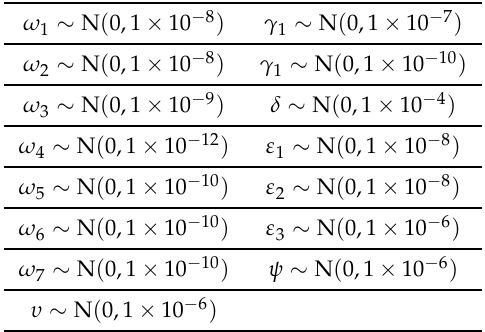
Figure 11. Initial capacity value effect on battery capacity estimation. Table 1. Characteristics of the added